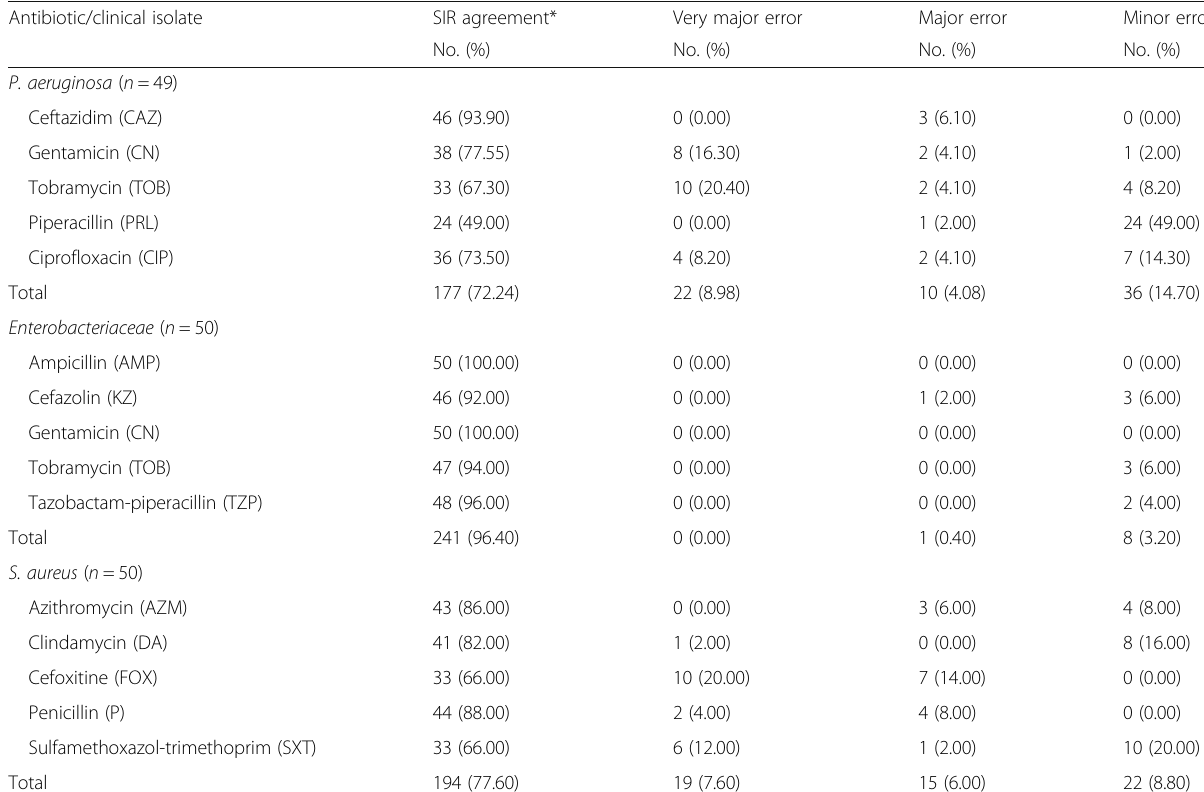
Table 3 Antibiotic susceptibility test results of clinical bacterial isolates on MHA versus NA using CLSI zone size interpretative table HIPH, Alexandria, 2015 – 16 Antibiotic/clinical